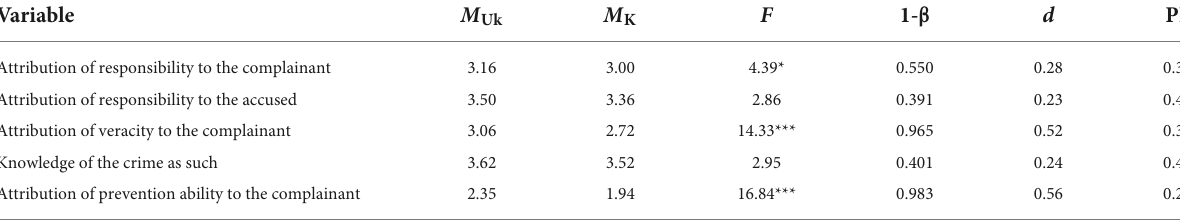
TABLE 6 Univariate effects on the attributional biases for the perpetrator factor. Variable M